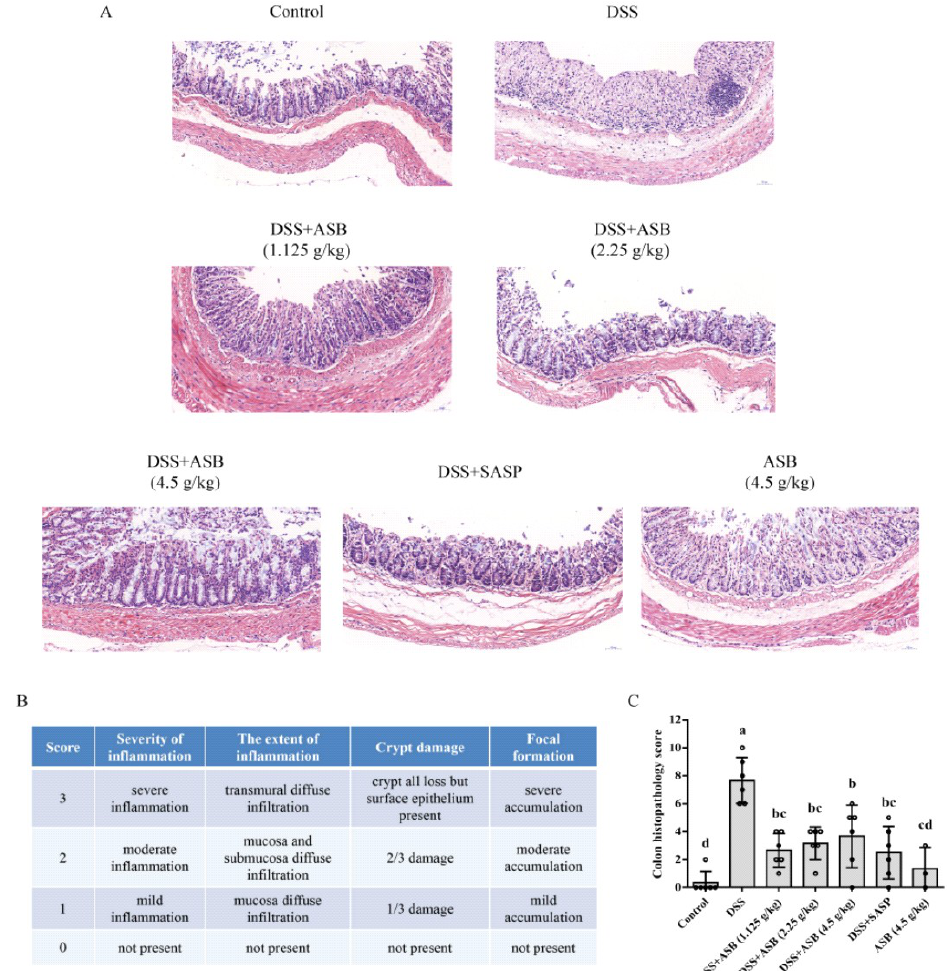
Figure 3. E ff ect of ASB on histopathological changes of mice in DSS-induced colitis. ( A ) Histological analysis (scale bar: 50 µ m); ( B ) chart indicating scoring criteria for the evaluation of intestinal inflammation; ( C ) histological score. Results were expressed as mean ± SD ( n = 3~6). Colon histopathology score marked by the same letter is not significantly di ff erent. Significance is represented as p < 0.05.